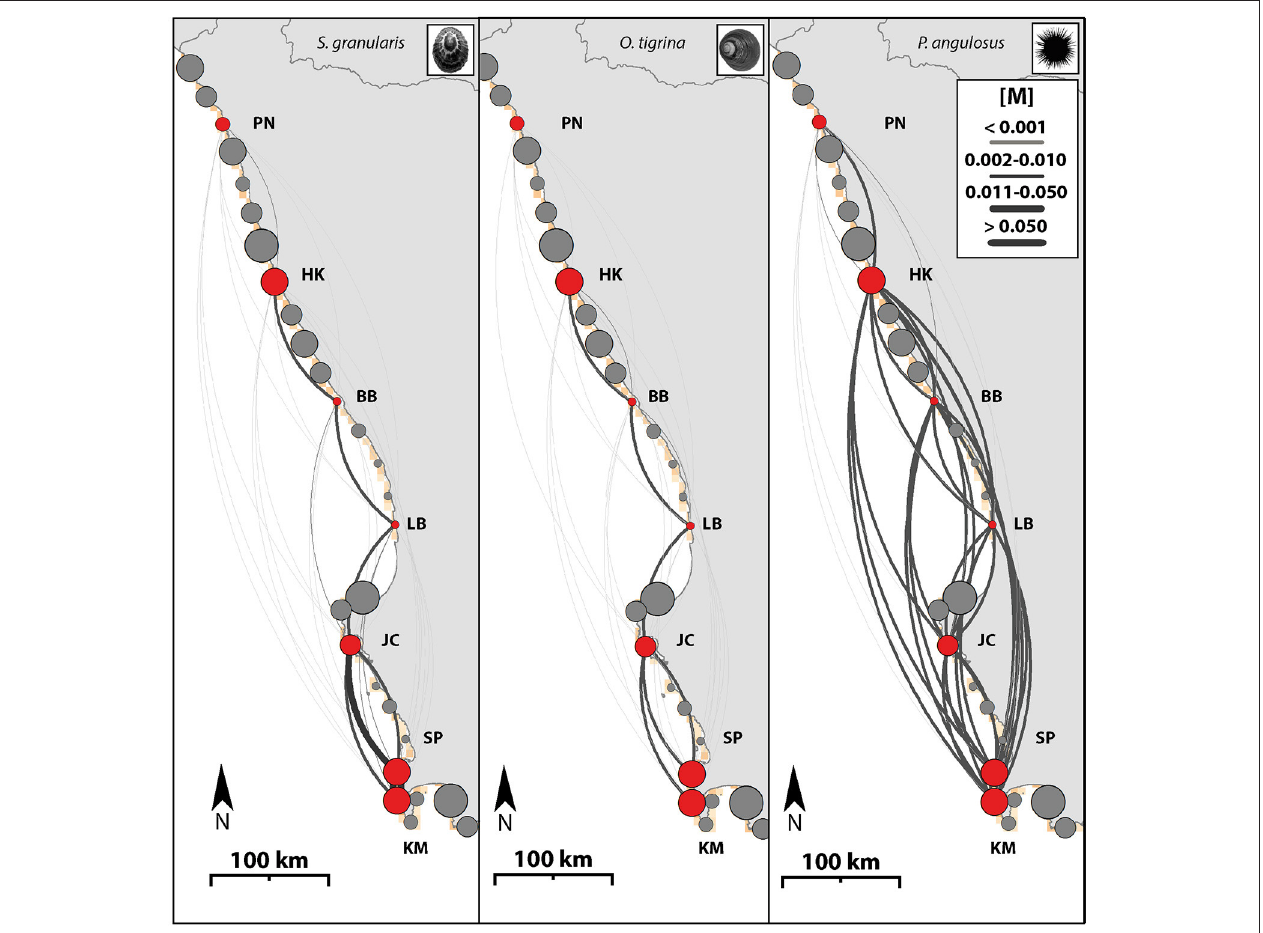
FIGURE 3 | Hydrodynamic dispersal networks. Map illustrating species connectivity networks based on the Migration matrix [M] through all potential habitat patches. Scutellastra granularis , Oxystele tigrina , and Parechinus angulosus . Arrow sizes are scaled to dispersal probability among sampling locations. Dispersal shown as calculated by the migration estimates between sampling locations (PN, Port Nolloth; HK, Hondeklipbaai; BB, Brandsebaai; LB, Lambertsbaai; JC, Jacobsbaai; SP, Sea Point; KM, Kommetjie). Arrows depict migration parameters. The size of the circles are in proportion to the relative amount of habitat in each patch. The colors: Red are sampled sites, gray are all other sites (unsampled). No urchins could be obtained from